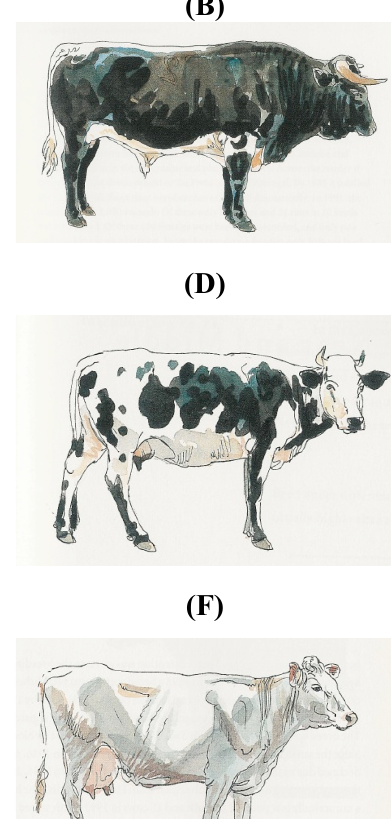
Figure 6. White-backed patterns in cattle of different origins. ( A ) Tux-Zillertaler (white finched); ( B ) Berrenda en Negro (Pinzgauer type white-backed); ( C ) Blacksided Trondheim and Nordland (color-sided); ( D ) Dagestan Mountain (white headed, color sided); ( E ) Ennstal Bergscheck (half white, color-sided) and ( F ) North Finncattle (color pointed).